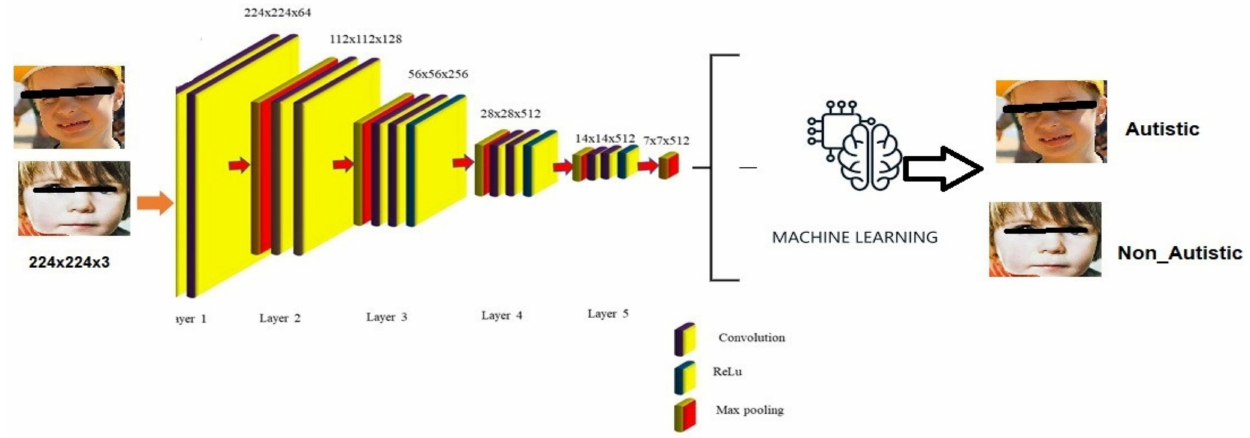
Figure 8. VGG-16